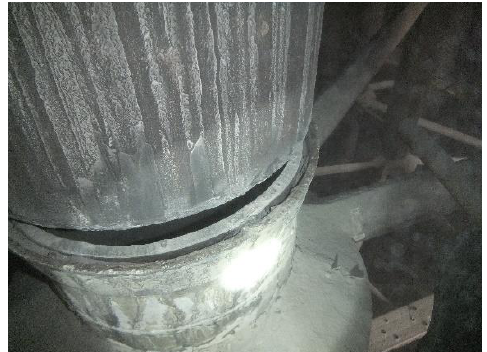
Figure 11. The dipleg fracture in the commercial FCC